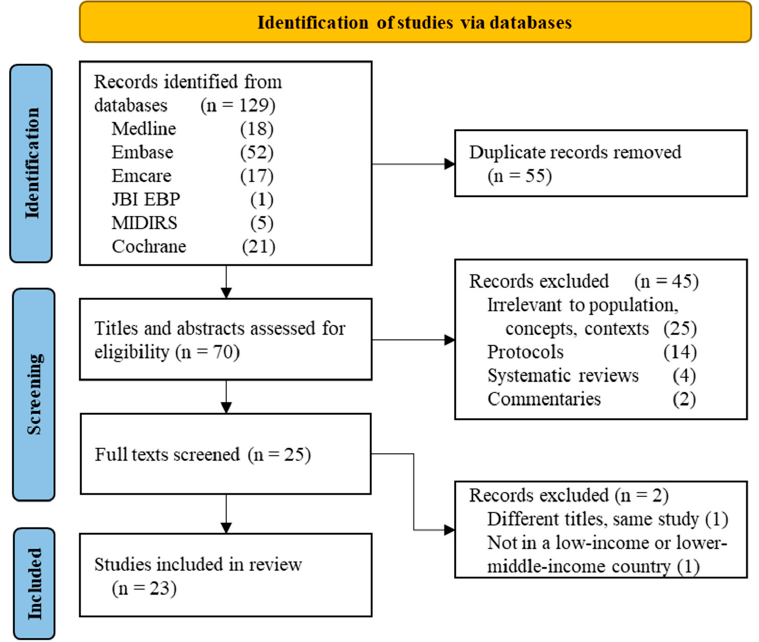
Figure 1. Study flow chart